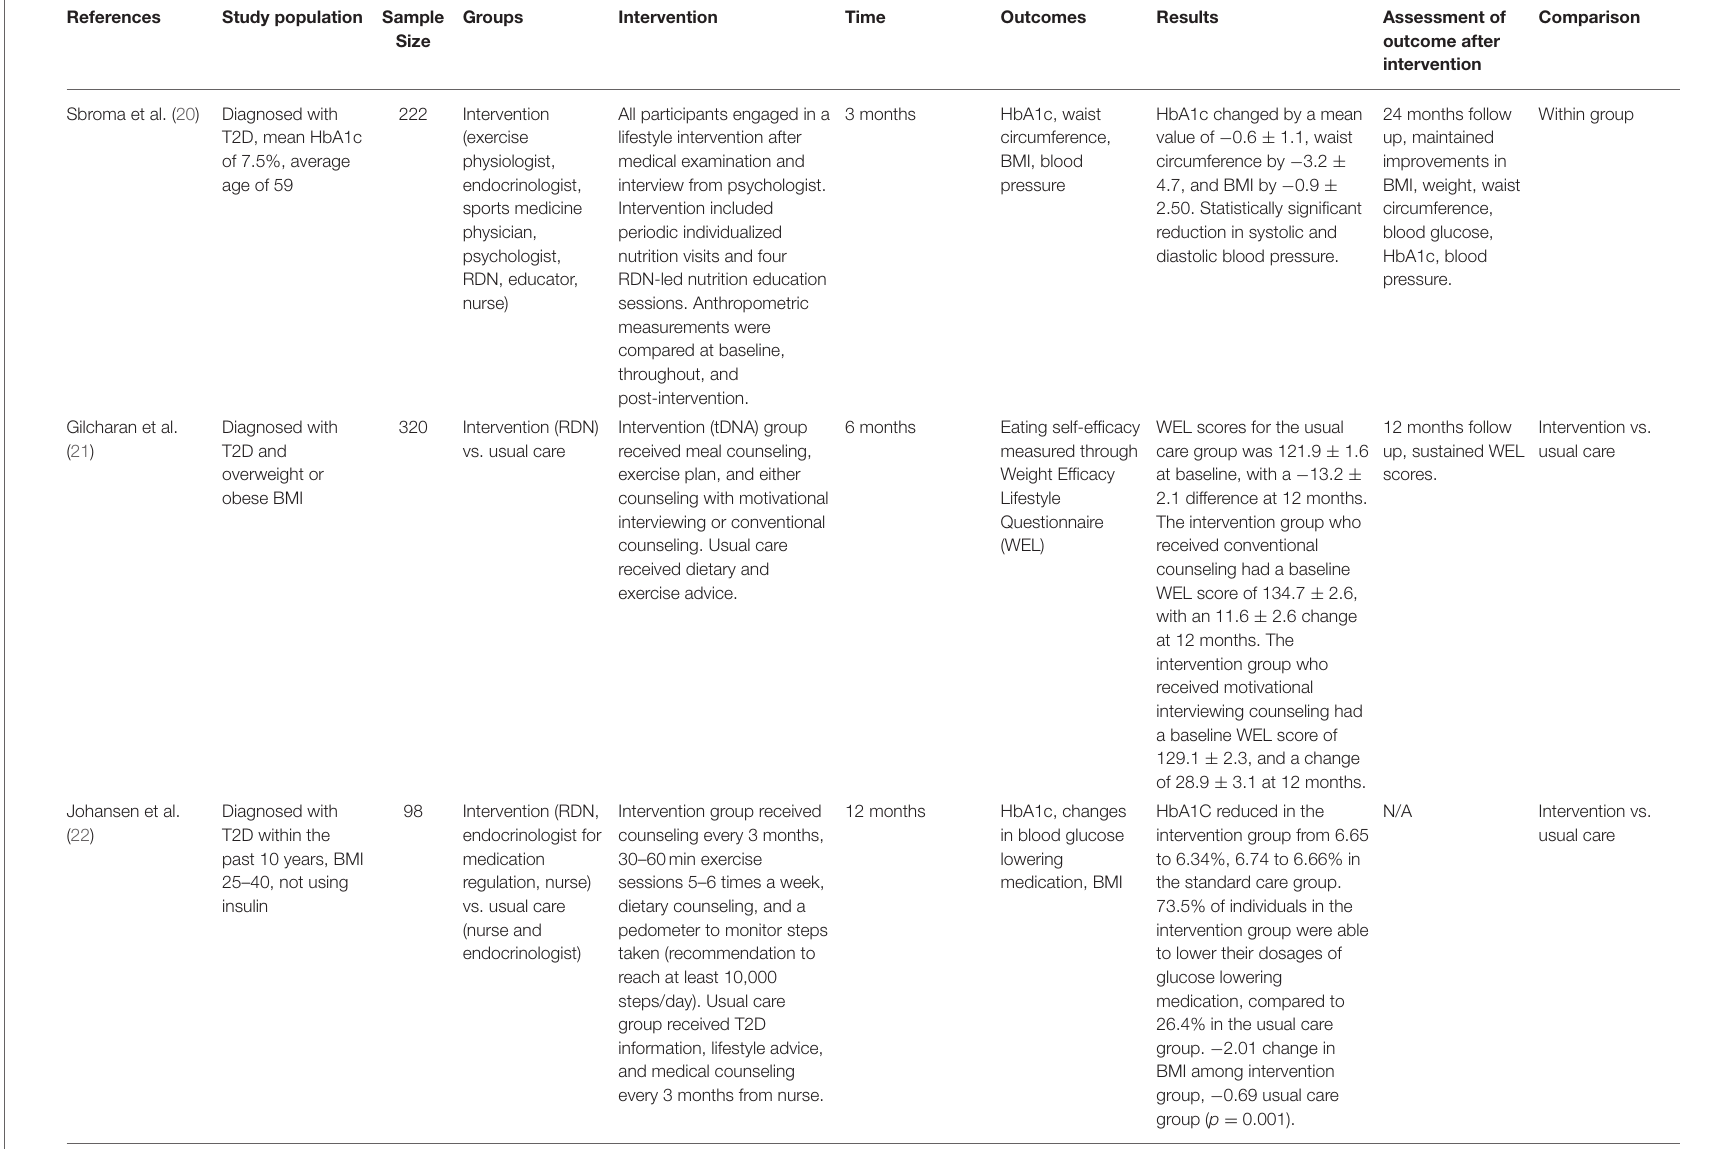
TABLE 1 | Summarized results of studies meeting literature search and review